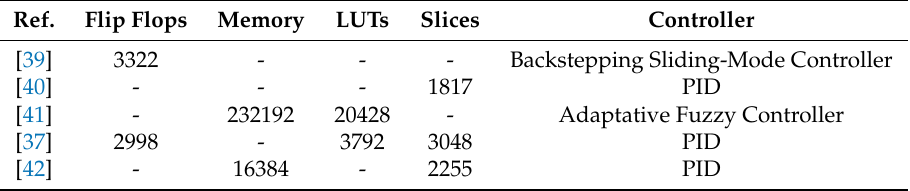
Table 9. Comparison of resources consumed in similar